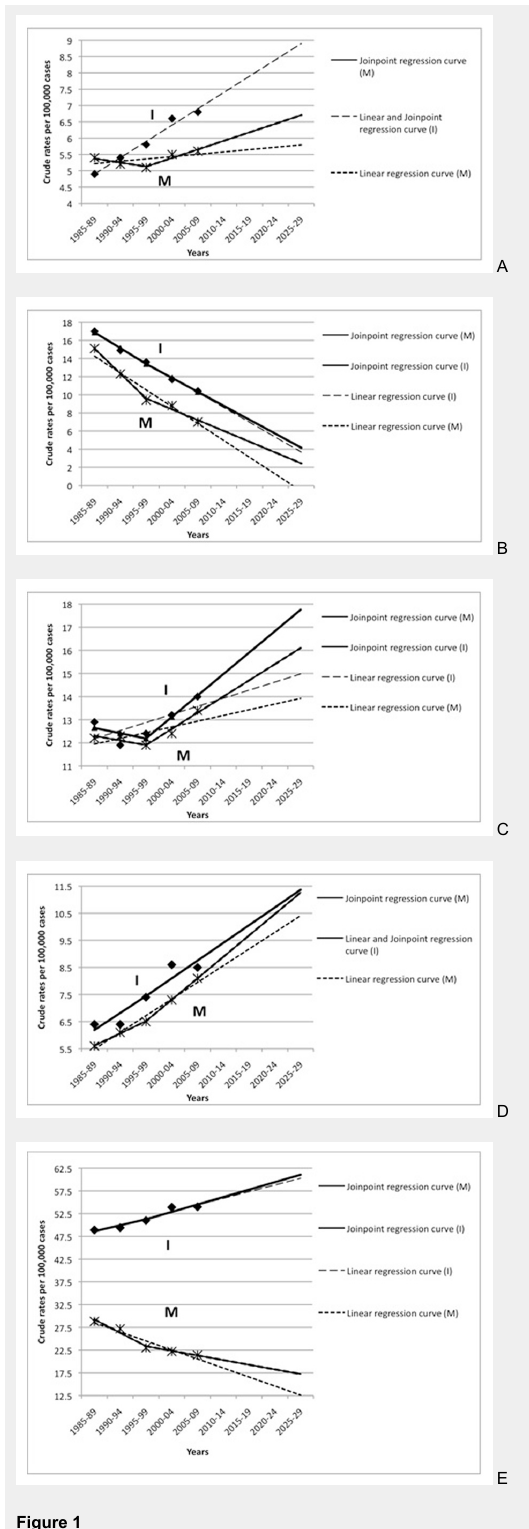
Crude incidence (I, diamonds represent the figures extracted from STAT-TAB) and mortality (M, asterisks represent the figures extracted from STAT-TAB) rates (median per year per 100 000 inhabitants) from 1985‒89 to 2025‒2029 in Switzerland with linear and Joinpoint regression models. A Oesophageal